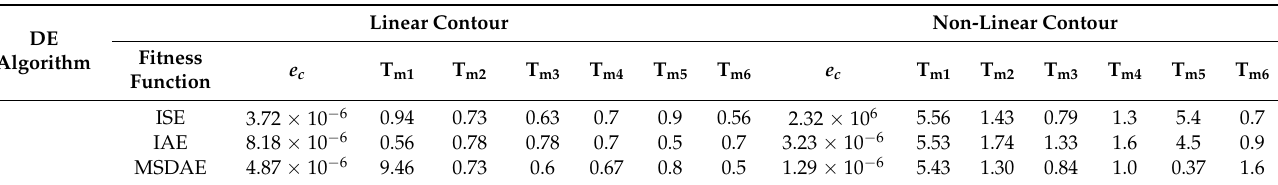
Table 6. Mean torques and contour